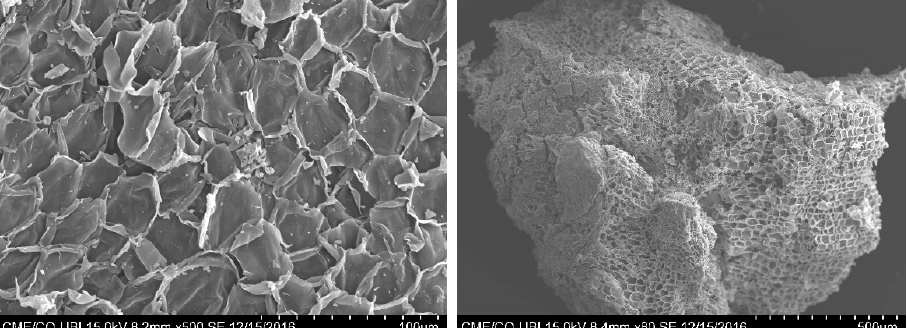
Figure 1. Scanning electron microscopy (SEM) micrographs of cell structure at high ( left ) and low ( right ) magnification of the expanded granulated cork (EGC).